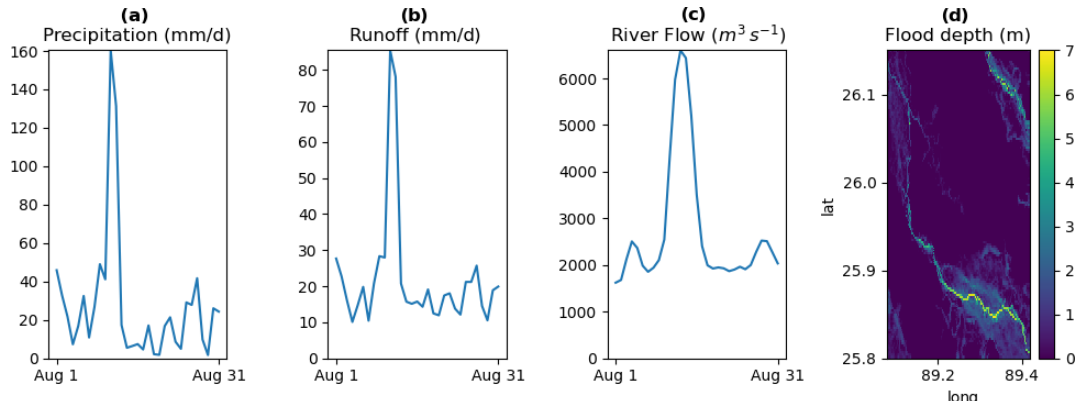
Figure 2. Visualization of model data: (a) precipitation (input), (b) runoff from FUSE, (c) river flow from mizuRoute and (d) flood depth from LISFLOOD-FP. Results are for the Teesta River, a tributary of the Brahmaputra River, for a flood event in August 2017. The precipitation and runoff values are catchment averages based on 0.1 ◦ resolution gridded data. The discharge shown is the value from the downstream section of this catchment (before joining the Brahmaputra). The flood depth is the maximum over August 2017 calculated at ∼ 270m resolution (shown over the downstream part of this